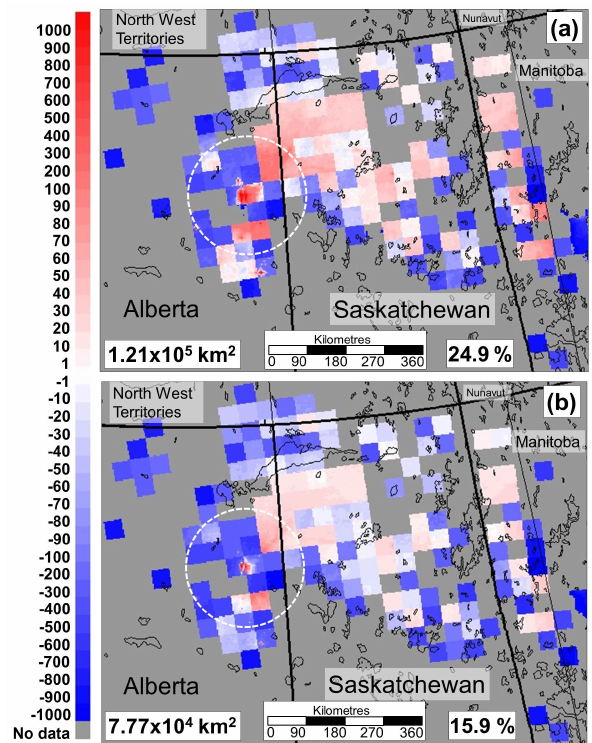
Figure 17. Predicted lake ecosystem critical load exceedances with respect to S dep , NEG-ECP (2001) methodology (eqha − 1 yr − 1 ). (a) Exceedances calculated using original GEM-MACH S dep . (b) Predicted exceedances calculated using GEM-MACH S dep scaled using precipitation deposition observations. Circled region: 140km radius diameter circle around the Athabasca oil sands.